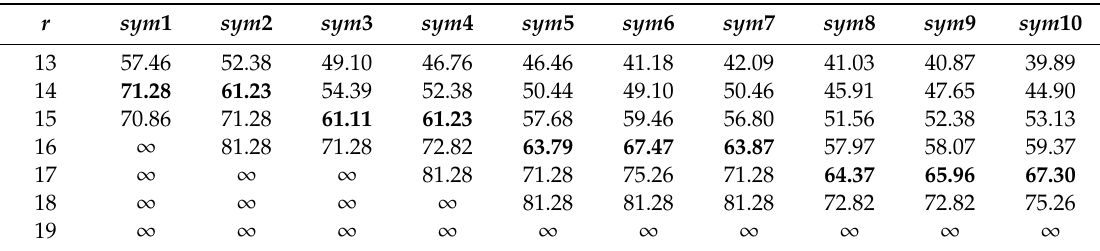
Table 5. Calculation results ( PSNR , dB) of 3D medical images (with 12 BPC) DWT by using bit-width r of symlets filters coe ffi cients.